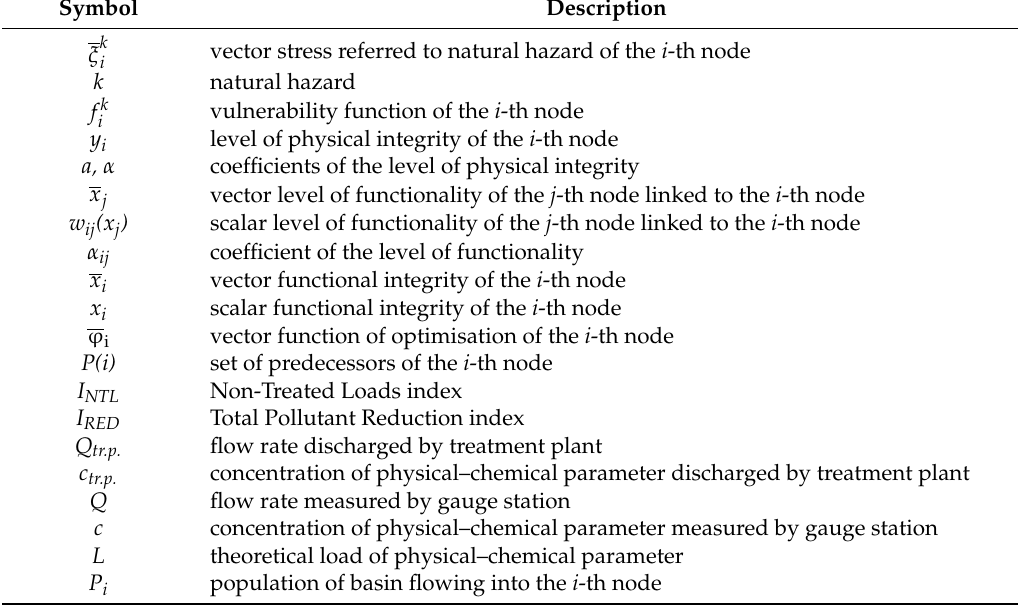
Table 3. List of main